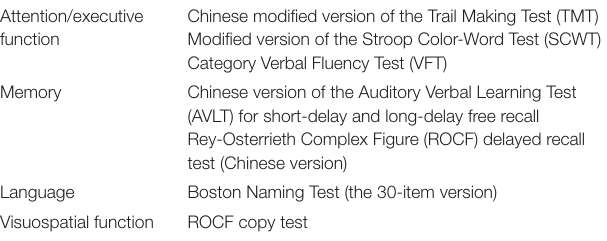
TABLE 1 | Neuropsychological tests used to evaluate cognitive status. Attention/executive